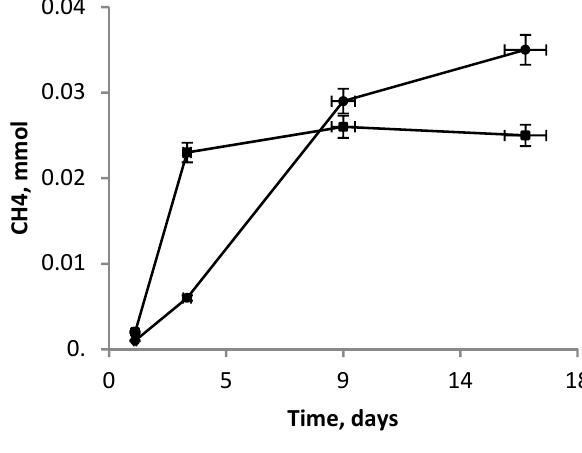
Figure 4. Methane formation by M. mazei JL01 with acetate (circle) and in cooperation with S. associata GLS2 T without any substrates (square). The temperature of cultivation was 28